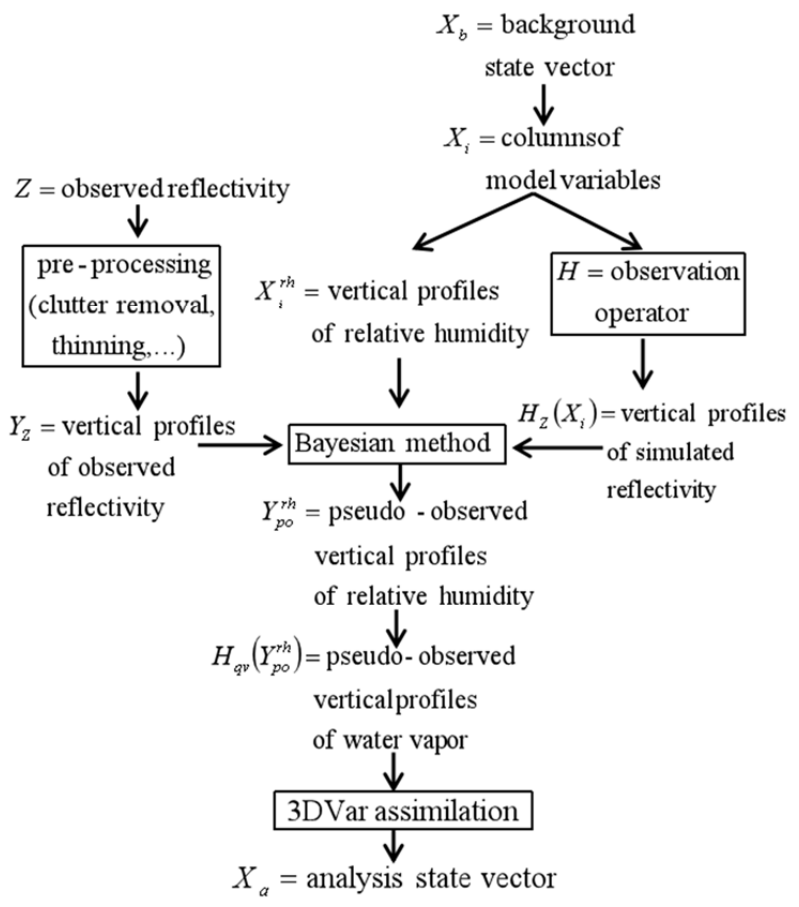
Figure 1. Flowchart of the sequence of operations of water vapor retrieval and assimilation.